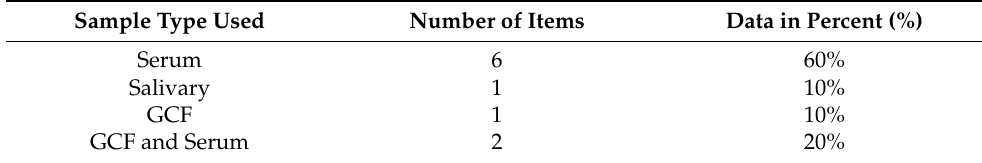
Table 4. Type of Sample used in each Study for Analysis.